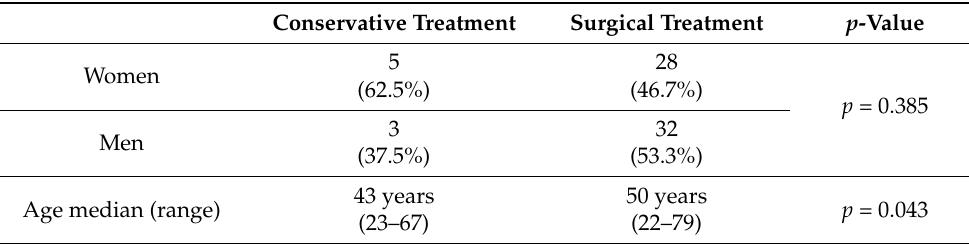
Table 1. Descriptive statistics of demographic in the study group; Median age is presented in years with range given in the brackets.